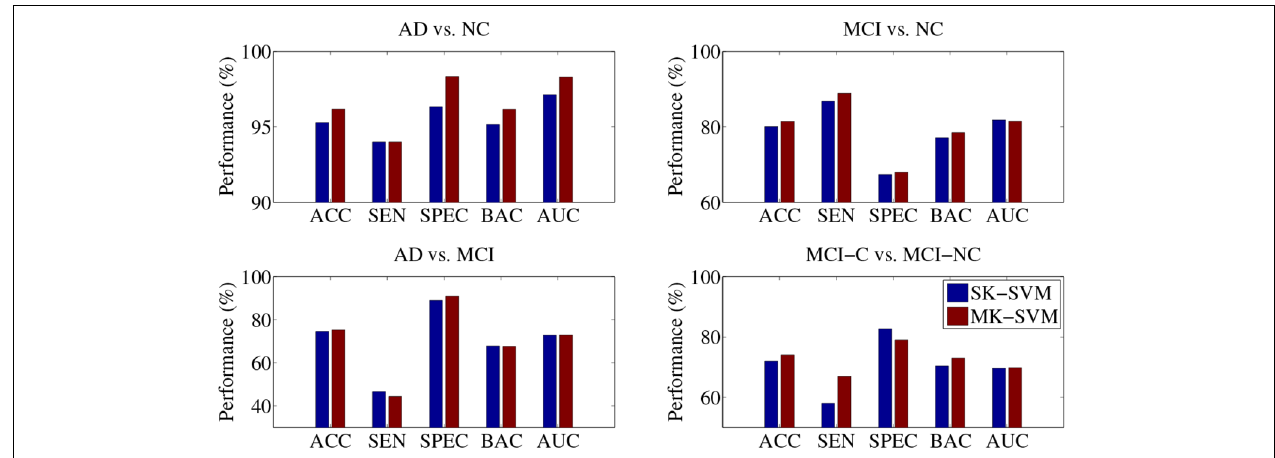
FIGURE 4 | Performance comparison between SK-SVM and MK-SVM in four binary classifications. For both methods, the feature selection was performed on the concatenated feature vectors with the proposed subclass-based multi-task learning.